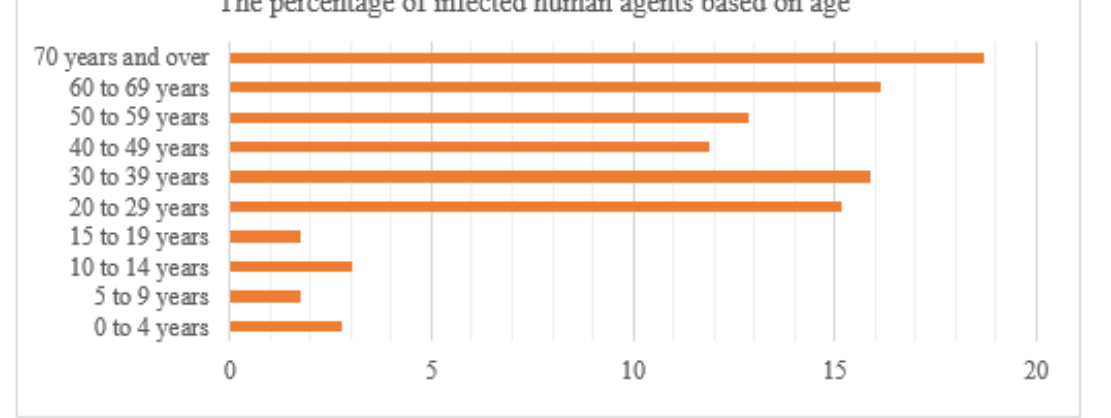
ISPRS Int. J. Geo-Inf. 2022 , 11 , x FOR PEER REVIEW Figure 7. The percentage of infected human agents based on age. Figure 7. The percentage of infected human agents based on age.